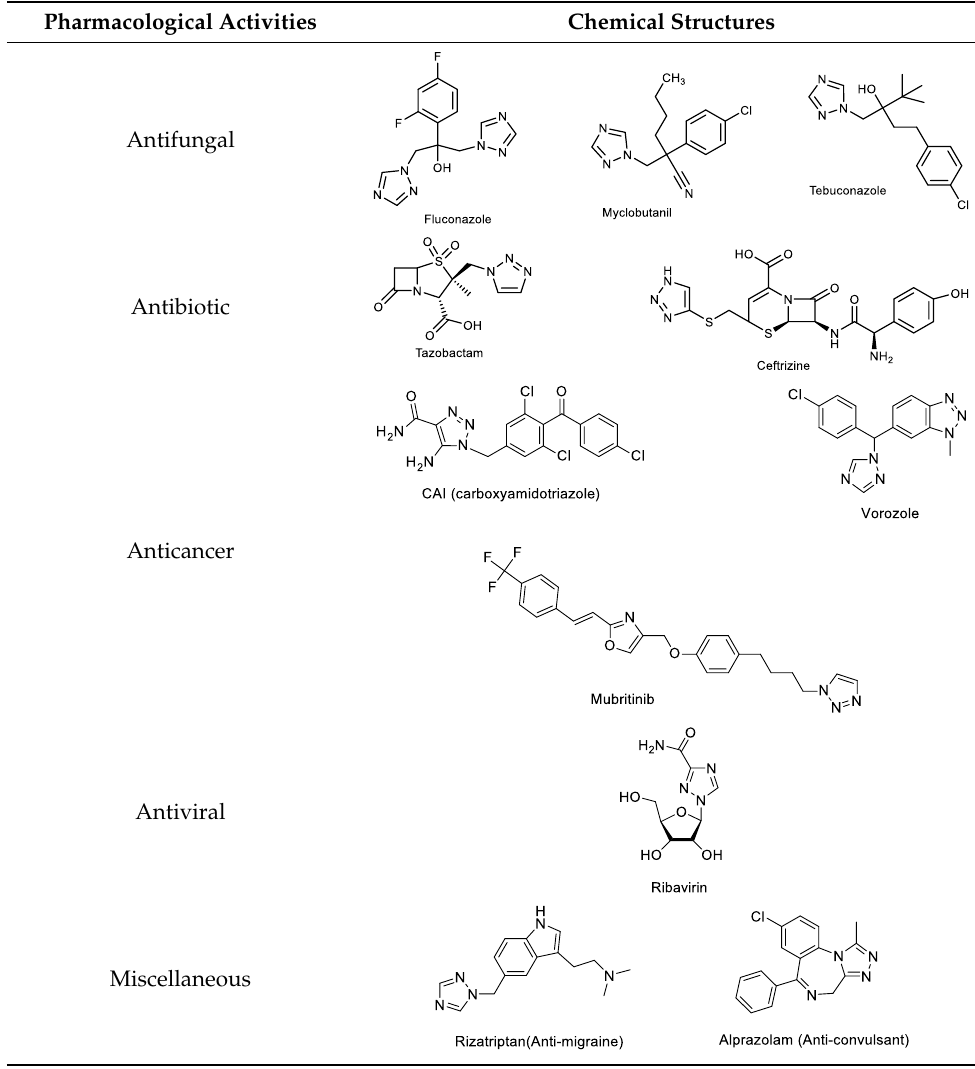
Figure 2. Isomers of triazole.